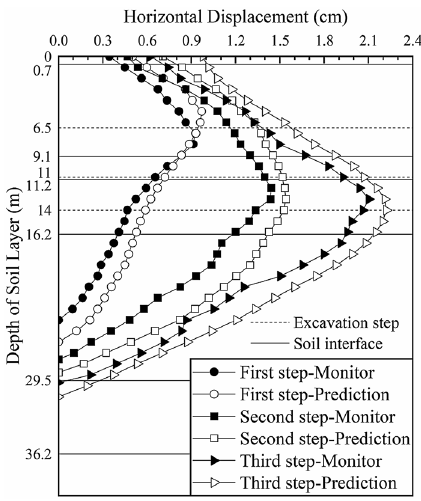
Figure 14. Deep horizontal displacement of section 4 before the